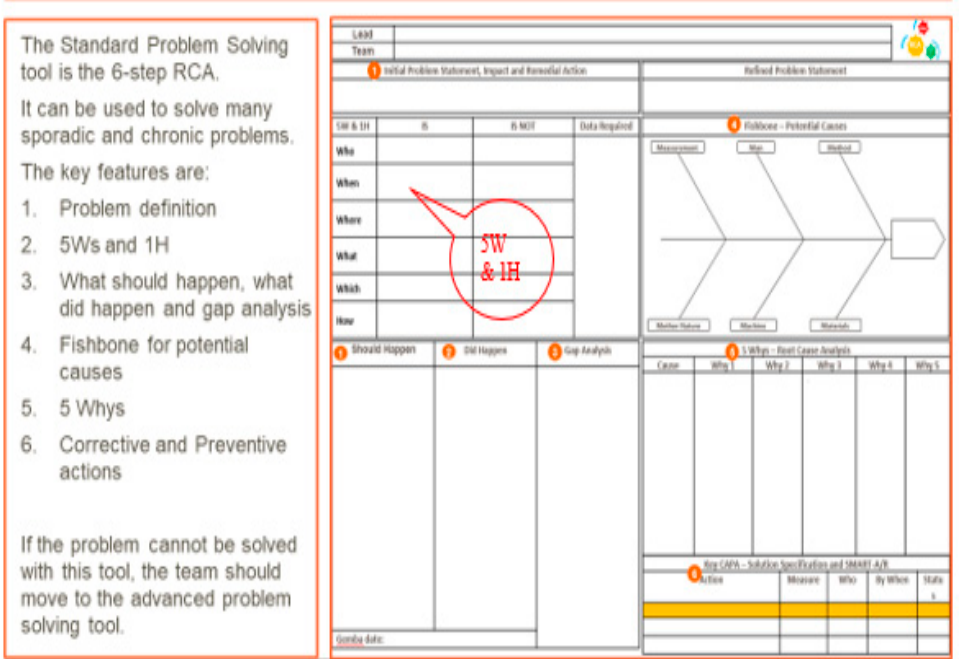
Figure 7. Six-Step Problem Solving Template based on a mix of the Six Sigma DMAIC methodology and the A3 structured.